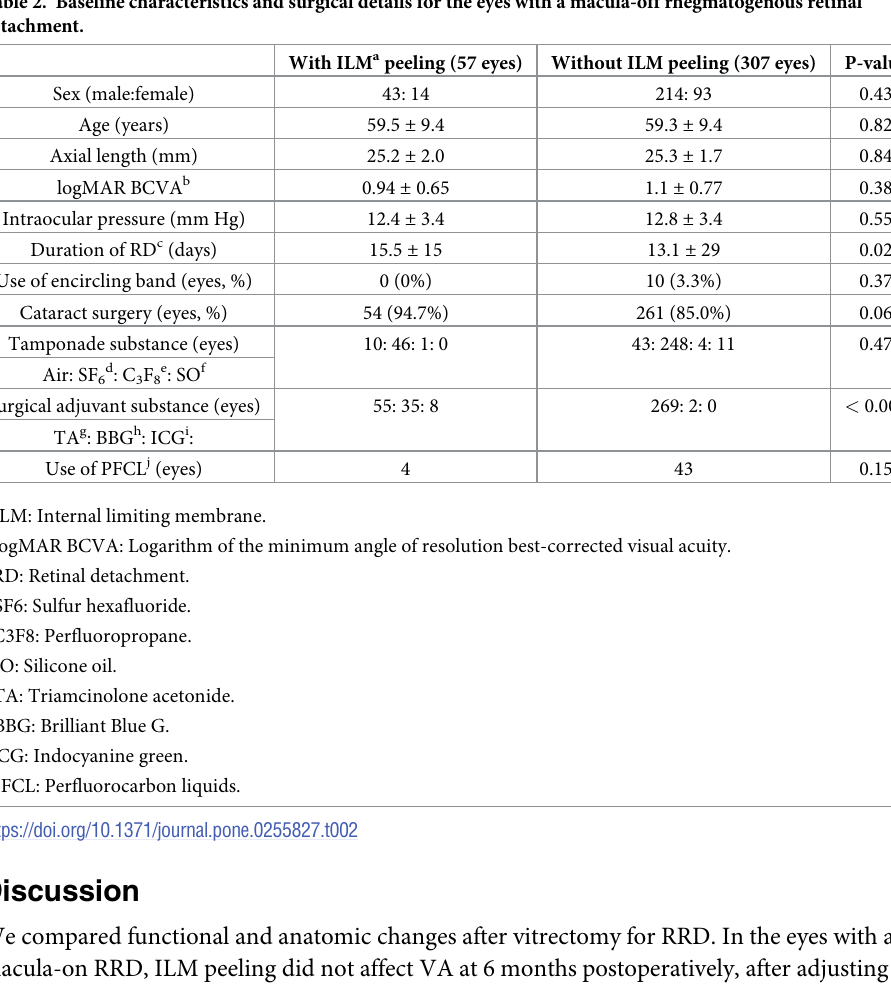
Table 3. Multiple linear regression analysis for VA at 6 months postoperatively in the eyes with a macula-on Rhegmatogenous Retinal Detachment (RRD). β value Standard error 95% confidence interval P-value Without internal limiting membrane peeling − 0.009 0.027 − 0.062 to 0.043 0.72 0.10